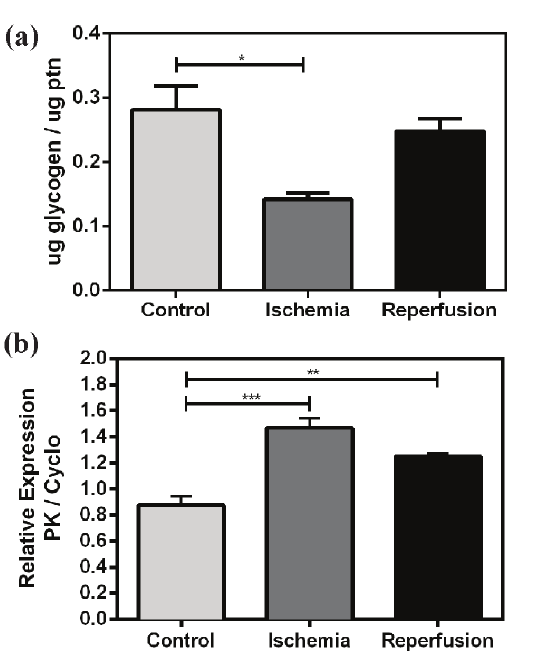
Figure 3 – Glycogen as important reserve to maintain anaerobic glycolysis and energy homeostasis during ischemia. ( a ) Decreased glycogen content during ischemia. ( b ) Increased Pyruvate kinase transcription level during ischemia and reperfusion. The statistical analysis used was ANOVA with Tukey post-test (*P<0,05)